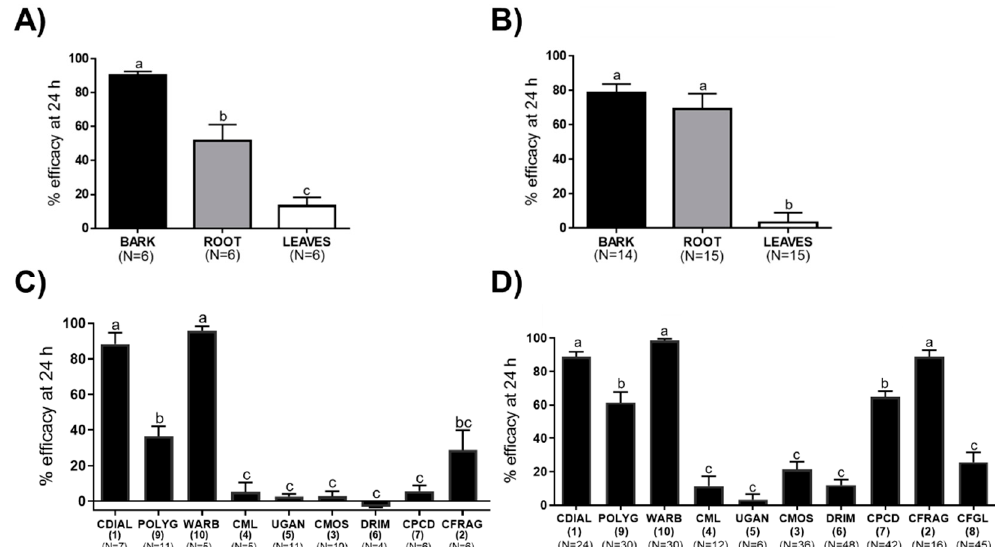
Figure 3. Insecticidal efficacy of plant extracts and isolated drimane sesquiterpenes against adult female ( A , C ) and larval ( B , D ) Ae. aegypti (Liverpool, LVP, strain). ( A , C ) Adulticidal efficacy was defined as the percentage of adults (after Abbott’s correction) that were incapacitated (dead or flightless) within 24 h when extract (2.5 μ g/mosquito) or compounds (5 nmol/mosquito) were applied to the thoracic cuticle of the adult females. Values are means ± SEM; N = number of independent replicates of 10 females each. ( B , D ) Larvicidal efficacy in 1st instar larvae was defined as the percentage (after Abbott’s correction) that died within 24 h when extract (50 μ g/mL) or compounds (100 μ M) were added to the rearing water (100 μ M). Values are means ± SEM; N = number of independent replicates of 5 larvae each. In all panels, lower-case letters indicate statistical categorization of the means as determined by a one-way ANOVA and Tukey’s multiple comparisons test ( p <0.05).